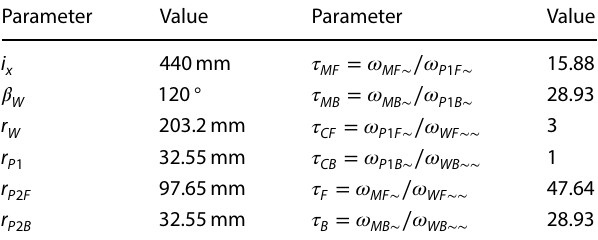
Table 1 Locomotion unit